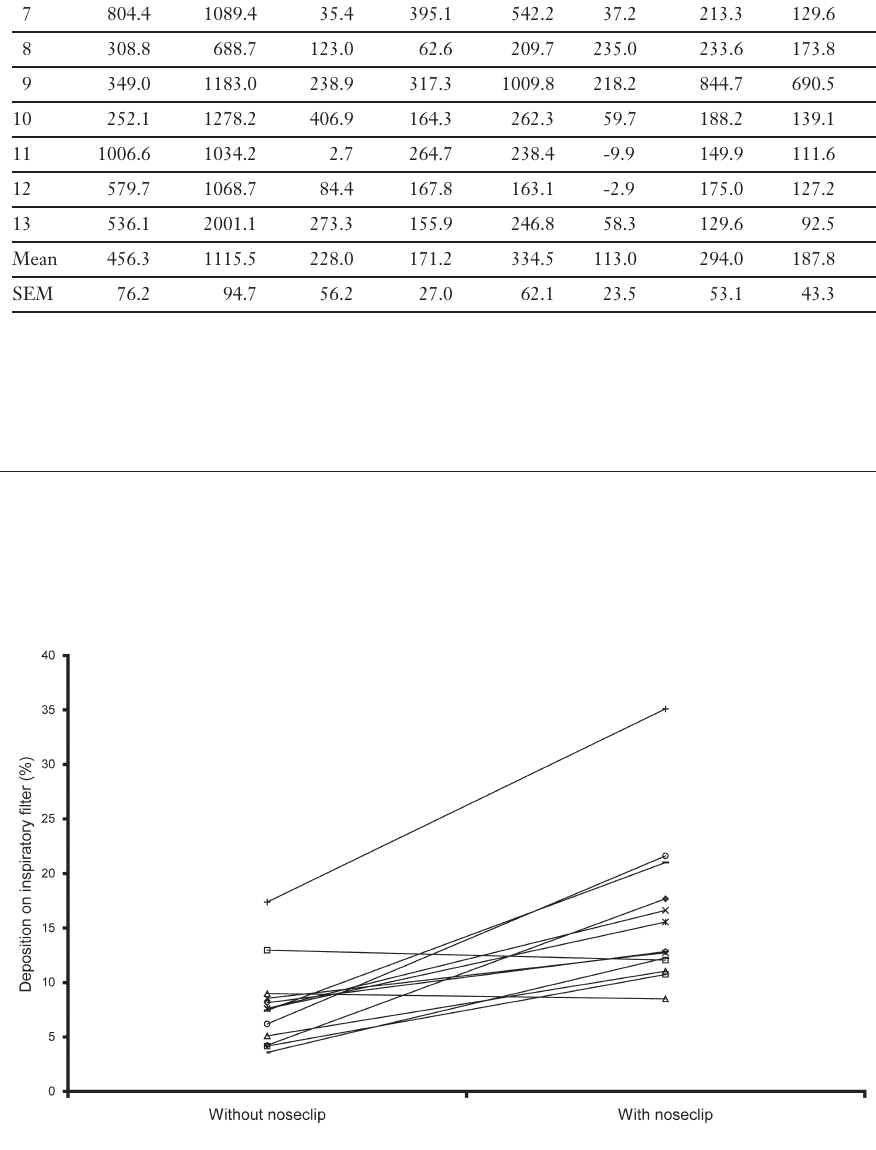
Individual and group mean data for inspi- ratory volumes and inspiratory and expi- ratory depositions, and ratio of inspira- tory drug delivery and expiratory drug loss both without (+NC) and with (–NC)